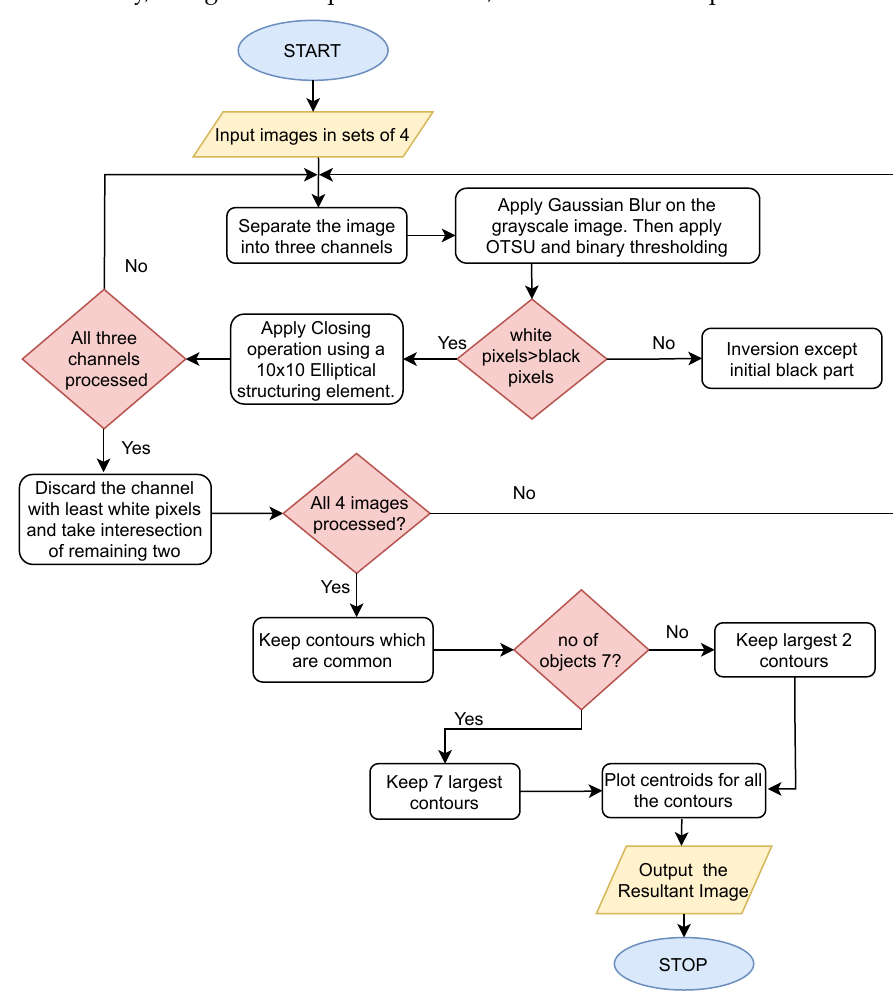
Figure 5. Flowchart showing all the image processing